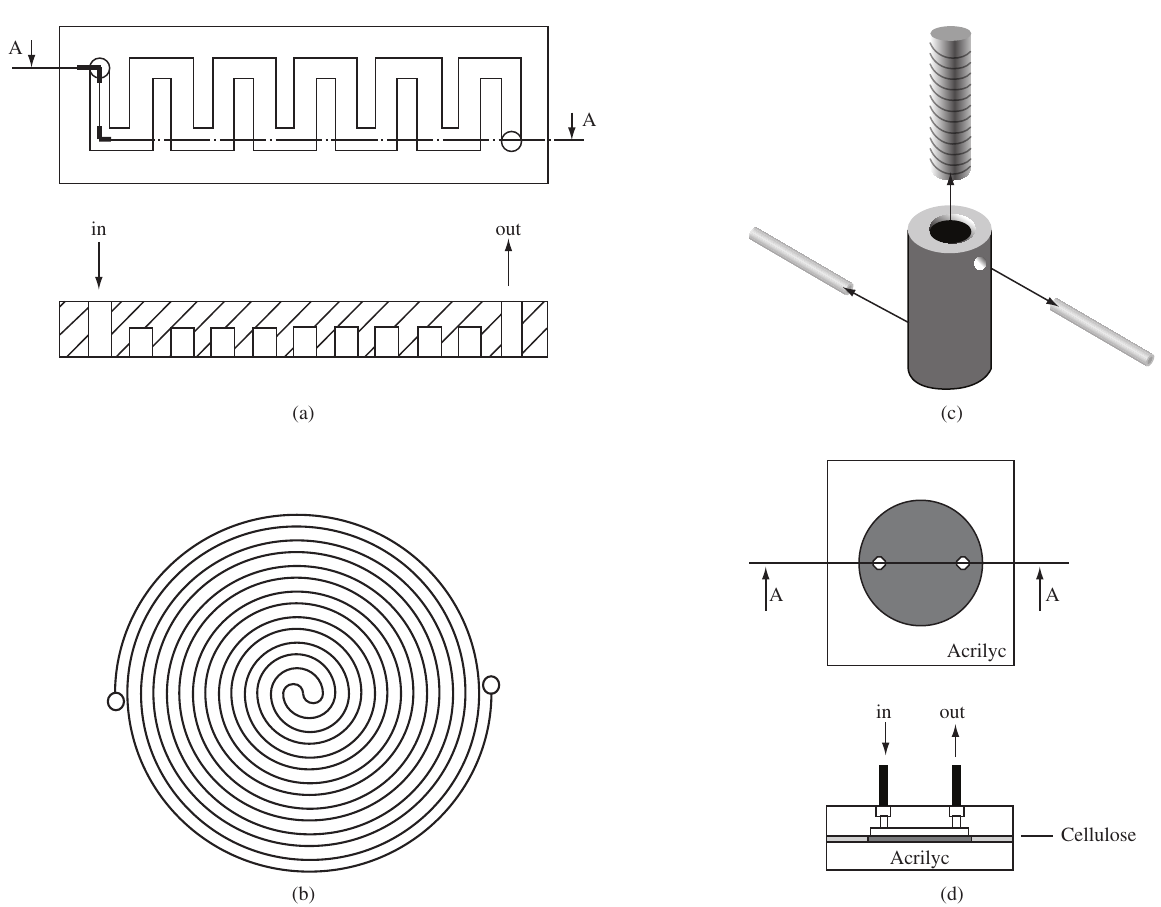
Figure 3. Sketch of the structures used: microchannels (a) chicane; b) spiral; and c) non-planar shape) and d) cavity. The letters “A-A” mean different view on the figures.